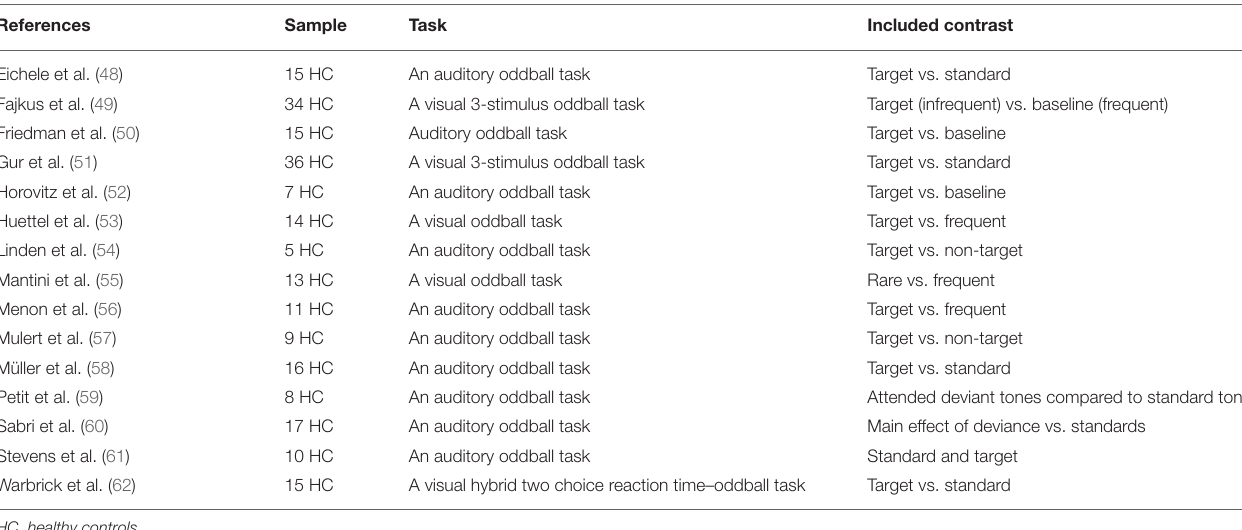
TABLE 2 | Studies of oddball in HC included in our SDM-PSI meta-analysis.